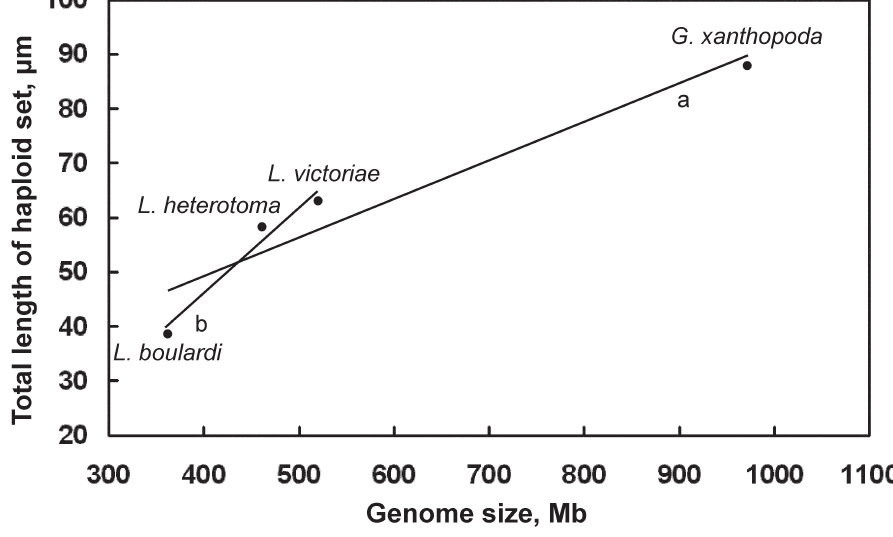
Figure 4. Distribution of genome size/chromosome length of Drosophila parasitoids. Mean values are given for each species. Trend lines: a for all species combined b for Leptopilina spp. (i.e. all species exclud- ing G. xanthopoda